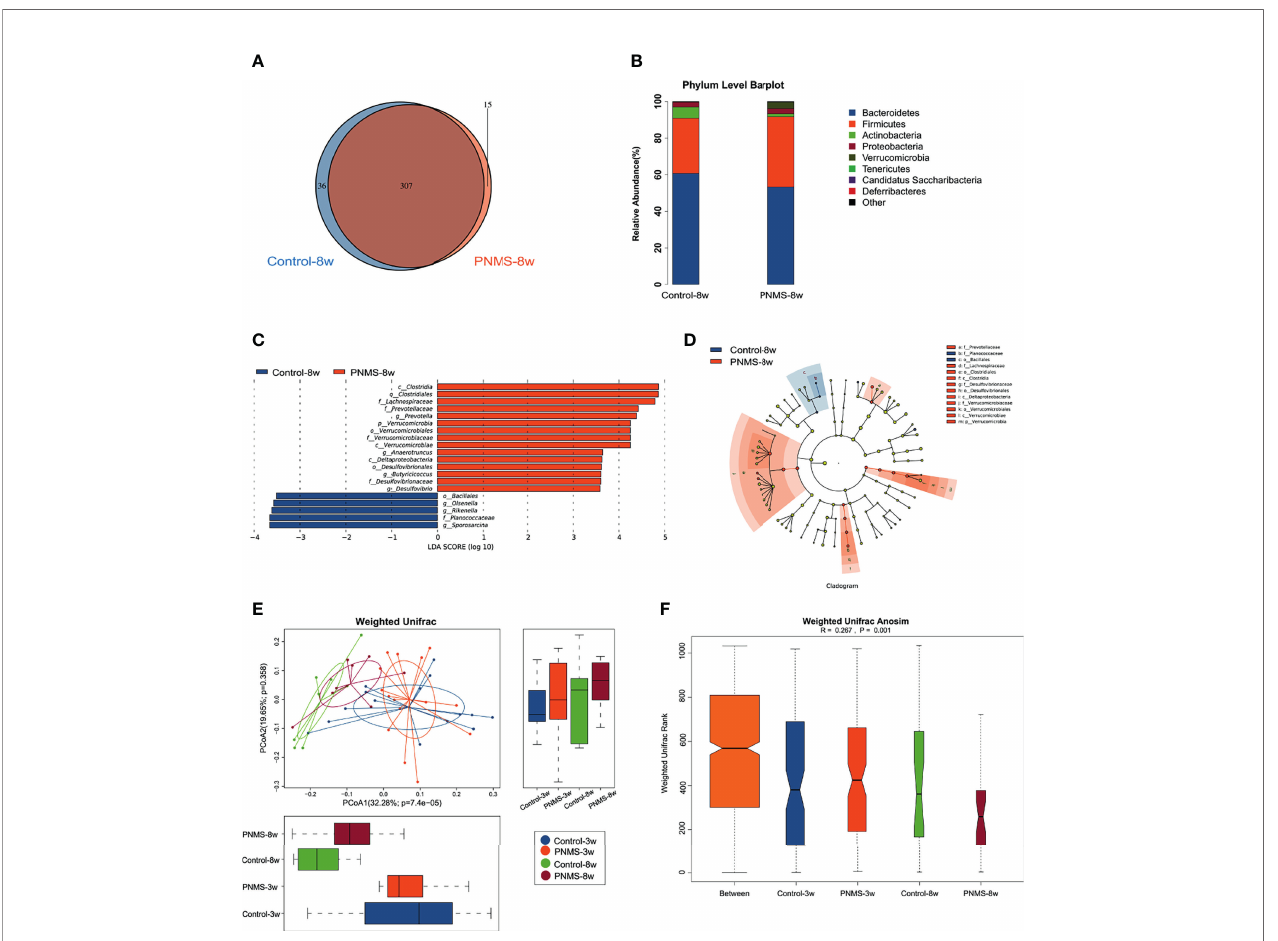
FIGURE 6 | Prenatal maternal stress has a long-term impact on the gut microbiota in the offspring. (A) Venn diagram of the operational taxonomic units (OTUs). (B) Gut microbiota composition at the phylum level. (C, D) Linear discriminant analysis (LDA) scores and the cladogram showed signi fi cant bacterial differences between the two groups by linear discriminant analysis effect size (LEfSe). (E, F) The gut microbiota of the 3- and 8-week-old offspring were put together for weighted Unifrac principal coordinate analysis (PCoA) and weighted Unifrac analysis of similarities (ANOSIM). PNMS , prenatal maternal stress. Control-3w ( n = 15) vs . PNMS-3w ( n = 15) vs . Control-8w ( n = 8) vs . PNMS-8w ( n =